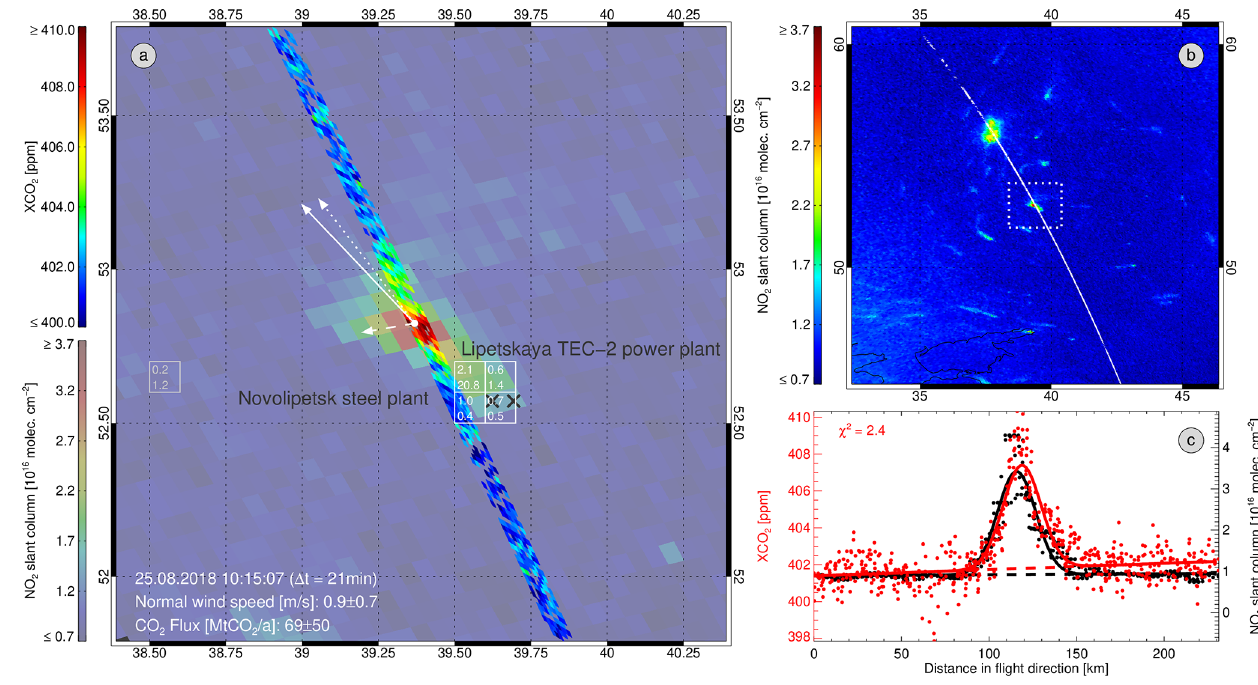
Figure 2. As in Fig. 1 but for Lipetsk on 25 August 2018.